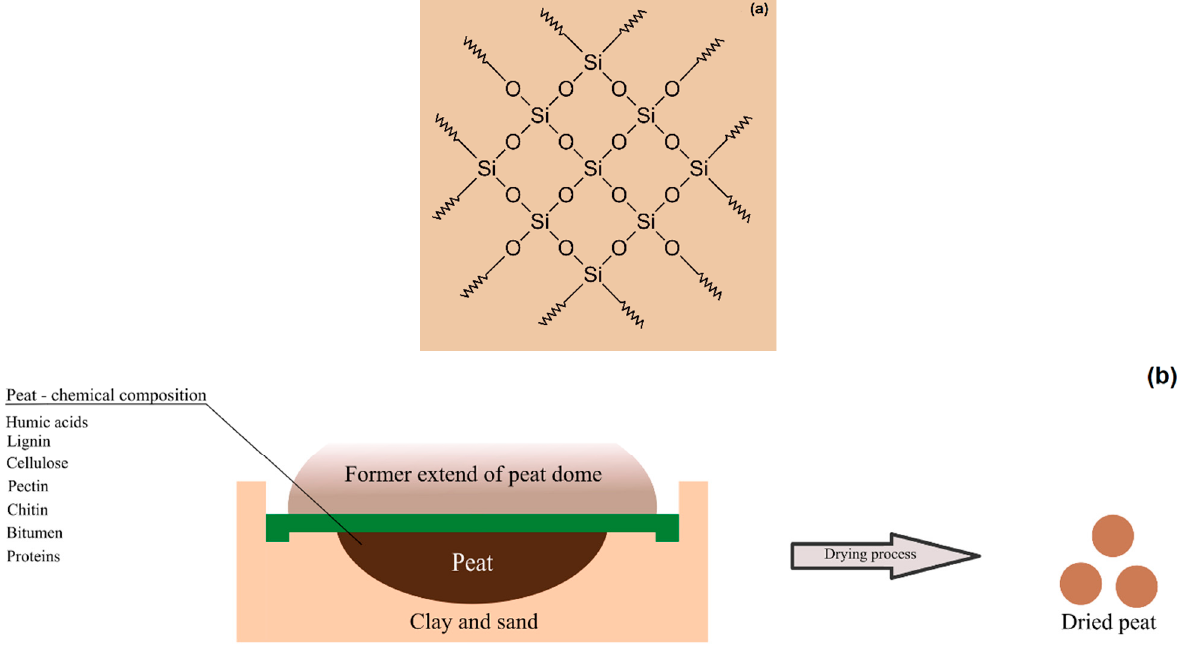
Figure 1. ( a ) Structural formula of silica as the basic component of diatomaceous earth and ( b ) the process of removal of water from peat by drying, taking into account the cross-section of the peat bed (authors’ own graphics).